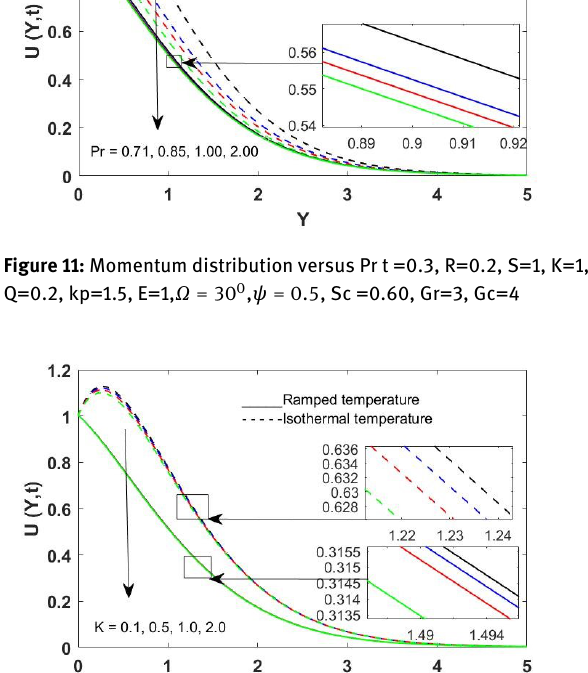
Figure 15: Temperature profiles for different values of Pr, where t =0.3, R=0.2,